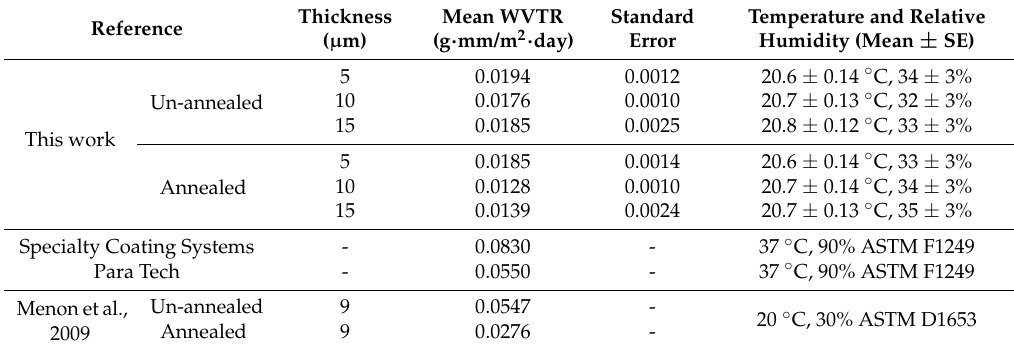
Table 1. Water vapor transmission rate (WVTR) measurements for different un-annealed and annealed Parylene film thickness.